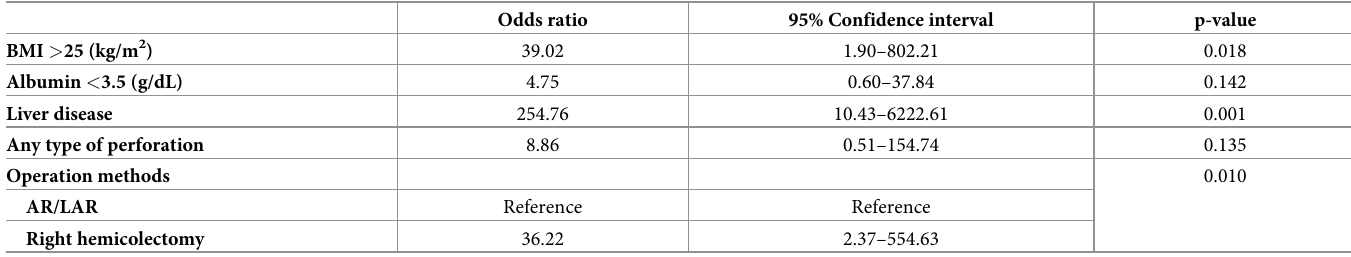
Table 4. Multivariable analysis for factors that affect surgical site infection.